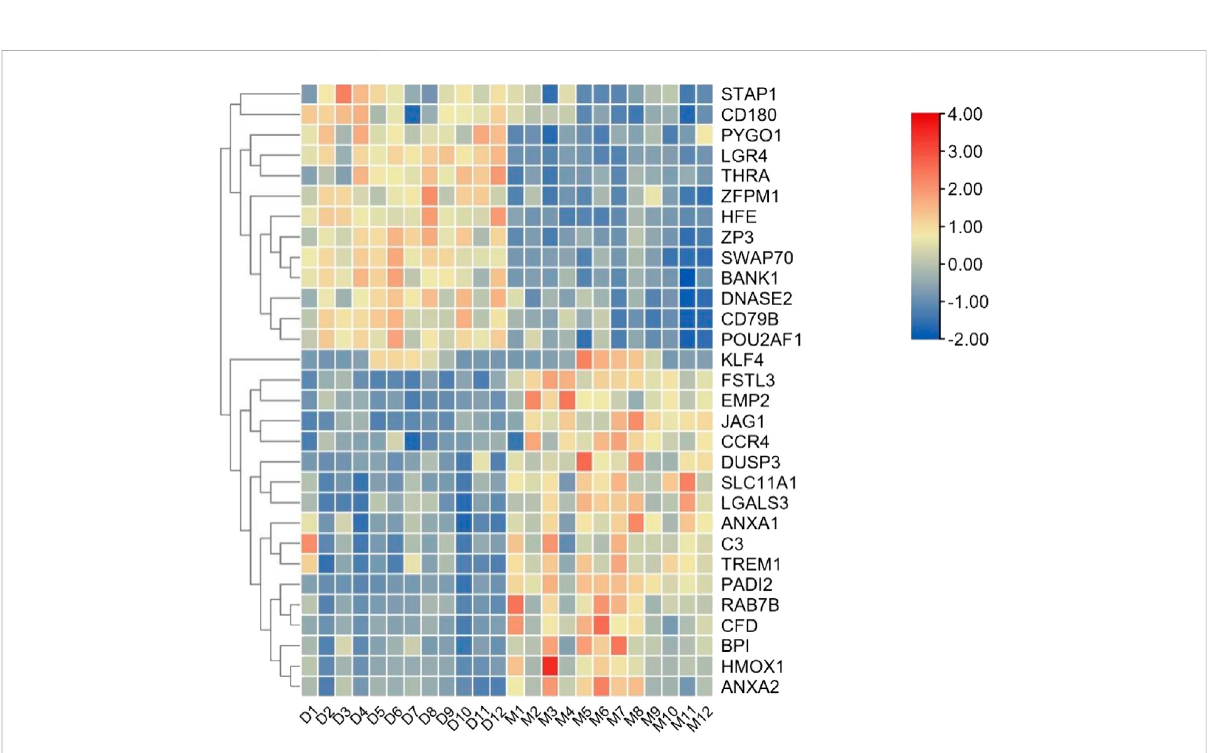
FIGURE 6 Expression pattern of 30 immune-related genes in blood. D is the control group, M is the implantation group, and the number is the